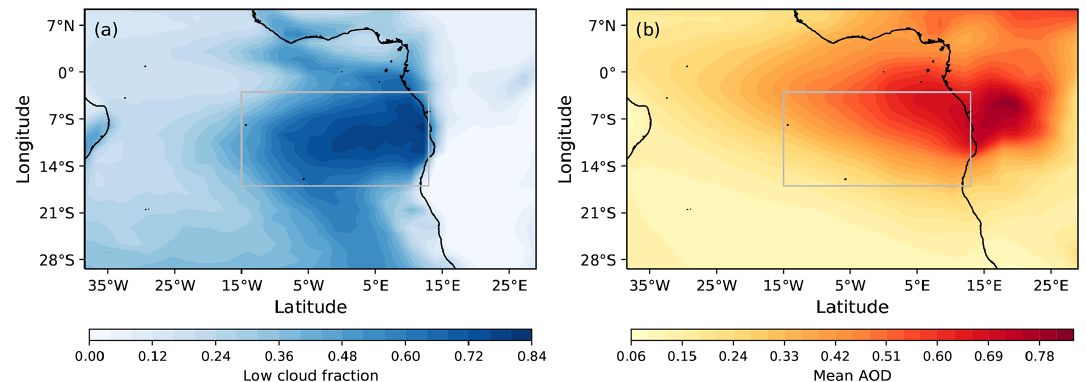
Figure 1. UKESM1-simulated mean (a) low-level cloud fraction and (b) aerosol optical depth (AOD) for July–September in 2016 and 2017. The domain, ranging from 30 ◦ S to 10 ◦ N and from 40 ◦ W to 30 ◦ E, is the area that this paper is interested in. The grey box (cloud box) on the map represents the area where the average low-level cloud fraction is above 0.6.